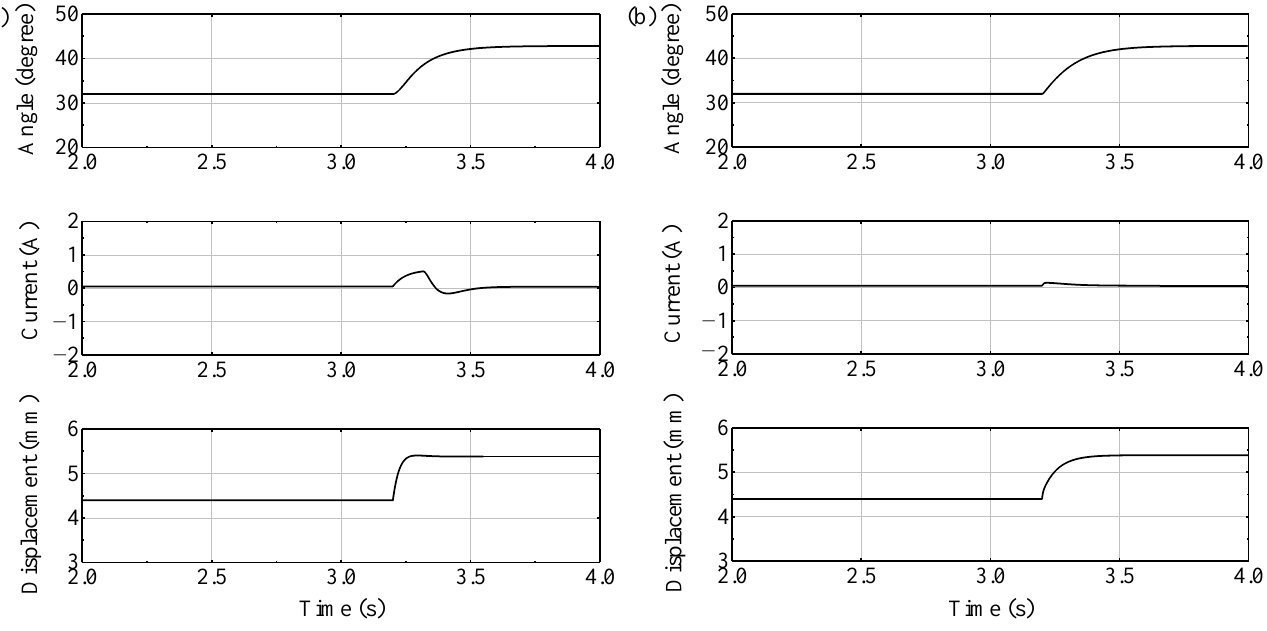
Figure 6. Simulation results of the force disturbance: ( a ) position loop fuzzy cascade control; ( b ) angle loop fuzzy cascade control.